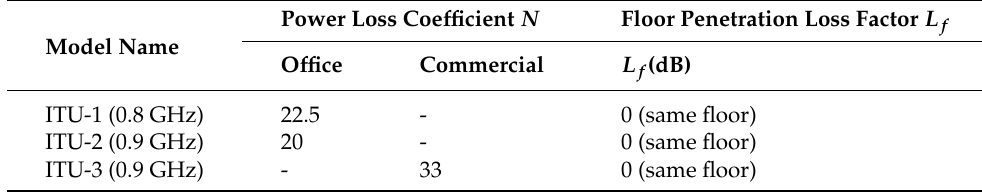
Table 1. Parameters of the ITU Model.